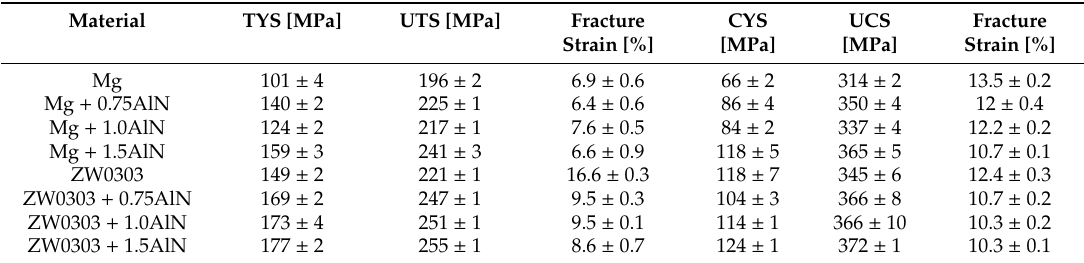
Figure 6. Stress-strain diagrams of extruded bars of pure Mg-based materials ( a , c ) and ZW0303-based materials ( b , d ) with different contents wt.% of AlN with respect to tension ( a , b ) and compression ( c , d ). Table 2. Results of compression and tensile tests at room temperature. UTS: ultimate tensile strength; TYS: tensile yield strength (0.2% proof stress); UCS: ultimate compressive strength; CYS: compressive yield strength (0.2% proof stress).